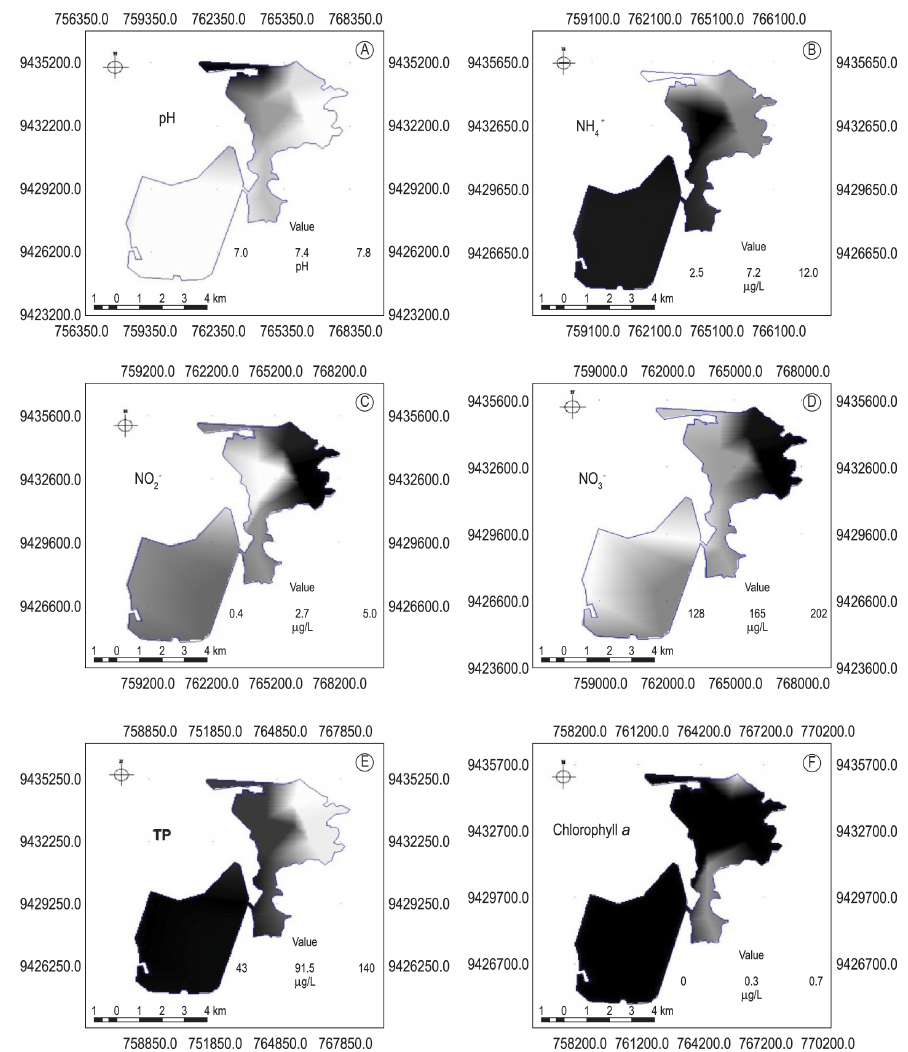
Figure 5. Variation of pH (A), nutrients (B – ammonium, C – nitrite, D – nitrate, E – total dissolved reactive phos- phorus) and chlorophyll a (F) along the brine circuit in Salina